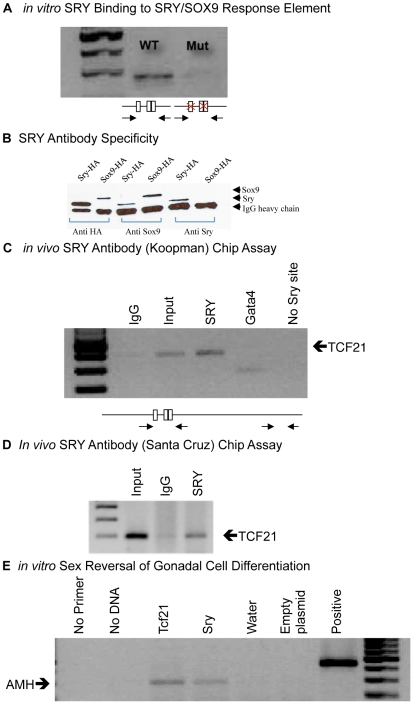
SRY in vitro and in vivo binding to
Tcf21.(A) Immunoprecipitation-based in vitro pulldown assay
was designed to test the physical binding of SRY protein with
Tcf21 promoter SRY/SOX9 response element
oligonucleotide. Recombinant SRY-HA tagged protein was bound in vitro to
250 bp Tcf21 promoter fragment containing three SRY
binding sites. An anti-HA antibody immunoprecipitated a fragment of
Tcf21 promoter containing all three SRY-binding
sites, whereas mutation of the bind site eliminated SRY binding. (B)
Antibody specificity for validating in vivo ChIP assay.
Recombinant SRY and SOX9 immunoprecipitation with anti-SRY (Santa Cruz,
CA) and anti SOX9 (Koopman) antibodies followed by western blot with
anti-HA antibody which was attached as a tag to those recombinant
proteins. The SRY antibody specifically pulled down SRY, whereas SOX9
antibody recognized both SRY and SOX9. (C and D) In
vivo carrier ChIP assay was performed using chromatin from
the embryonic testis from E13 male embryos (14–18 tail somite
stage). The anti-SRY antibody (Koopman) (C) and commercial anti-SRY
antibody (Santa Cruz, CA) (D) immunoprecipitated a fragment of
Tcf21 promoter containing SRY binding sites,
in vivo. Enriched DNA was amplified by primers
flanking SRY binding site and for non-specific enrichment PCR primers
were designed between −0.7 and −0.9 kb promoter which did
not contain any consensus binding site for HMG box proteins (no Sry
site). A control non-immune IgG (IgG) had no precipitation, while a
positive control input DNA (Input) did have Tcf21 PCR
product. A positive control GATA4 antibody (GATA4) precipitation also
pulled down a GATA4 site in Tcf21 promoter. (E)
Over-expression of TCF21 induced AMH expression in the E13 primary cells
derived from embryonic ovaries. The TCF21 or SRY over-expression (TCF21)
or (Sry) indicated, along with controls (No Primer, No DNA, Water and
Empty Plasmid), with positive PCR control of L19 gene (Positive). Data
is representative of a minimum of three different experiments.